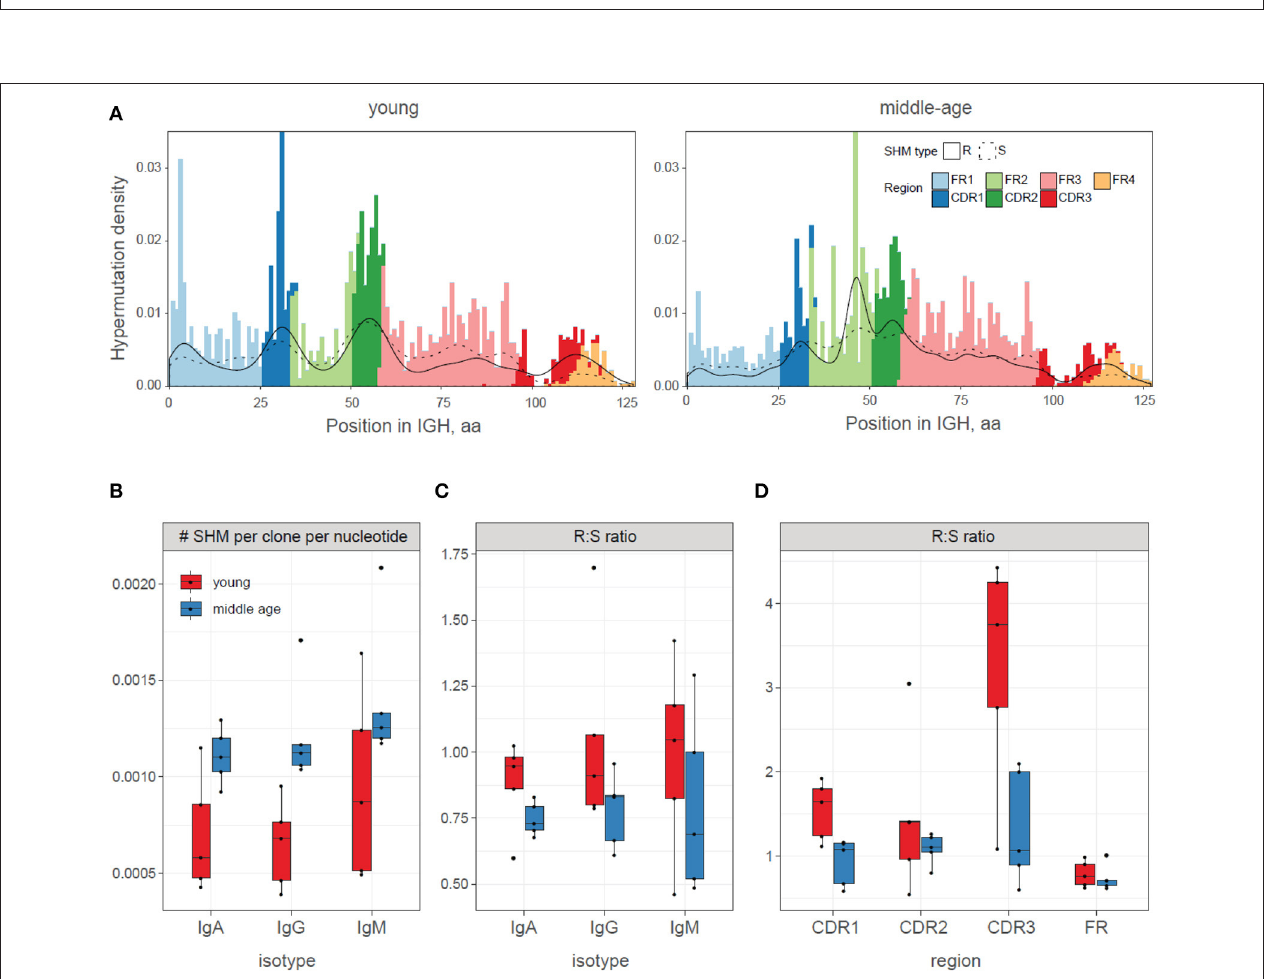
FIGURE 5 | Patterns of newly acquired somatic hypermutations in young and middle-age donors vaccinated with YF. (A) Summary profile of somatic hypermutations observed in the study. IGH regions are marked with color. The distribution of silent (S) and replacement (R) hypermutations are shown with dashed and solid lines, respectively. For CDR3 region, mutation analysis was done using the root as reference. Data were pooled for all young and all middle-age individuals. (B) Frequency of newly acquired somatic hypermutations (SHMs) in young (red) and middle-age (blue) donors. ANOVA p = 0.0005 for age, 0.14 for isotype. (C,D) Mean replacement:silent ratio (R:S ratio) for newly acquired somatic hypermutations (SHMs) in young and middle-age donors, for isotypes ( C , ANOVA p = 0.058 for age, 0.69 for isotype) and regions ( D , ANOVA p = 0.0013 for age, 0.00014 for regions).